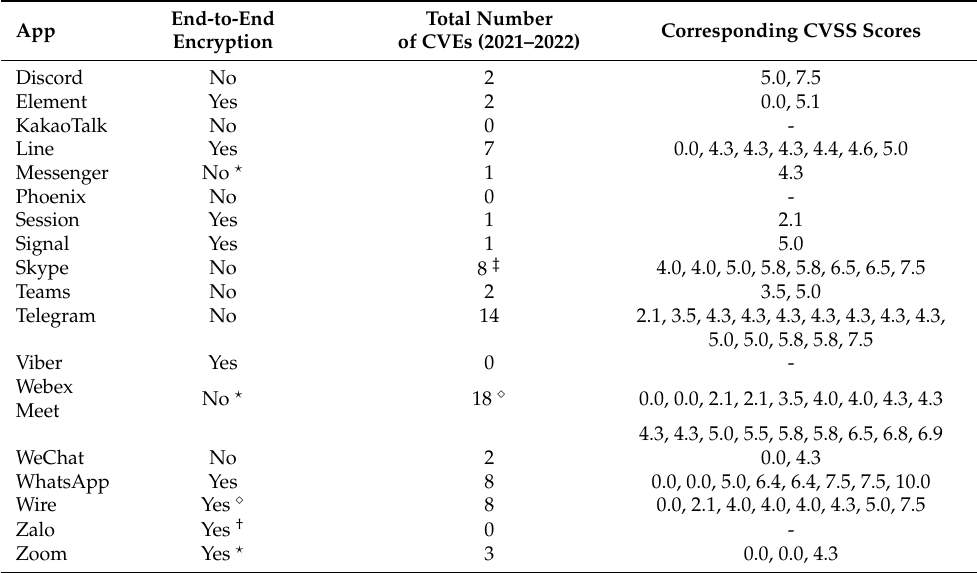
Table 6. Security aspects of